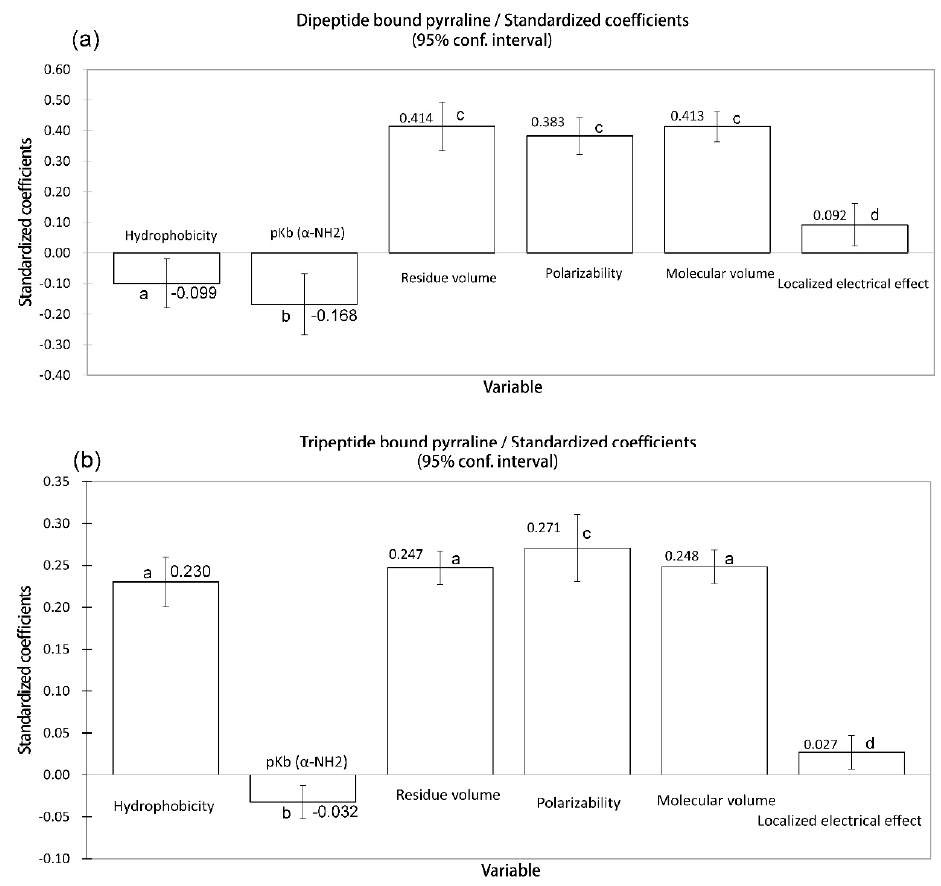
Figure 7. PLS regression standardized coefficients ( a ) for dipeptides and ( b ) for tripeptides. The importance of a given X-variable is proportional to its distance (coefficient value) from the origin (zero). The bars indicate 95% confidence intervals based on jack-knifing, bars with different letters have mean values that are significantly different ( p < 0.05).